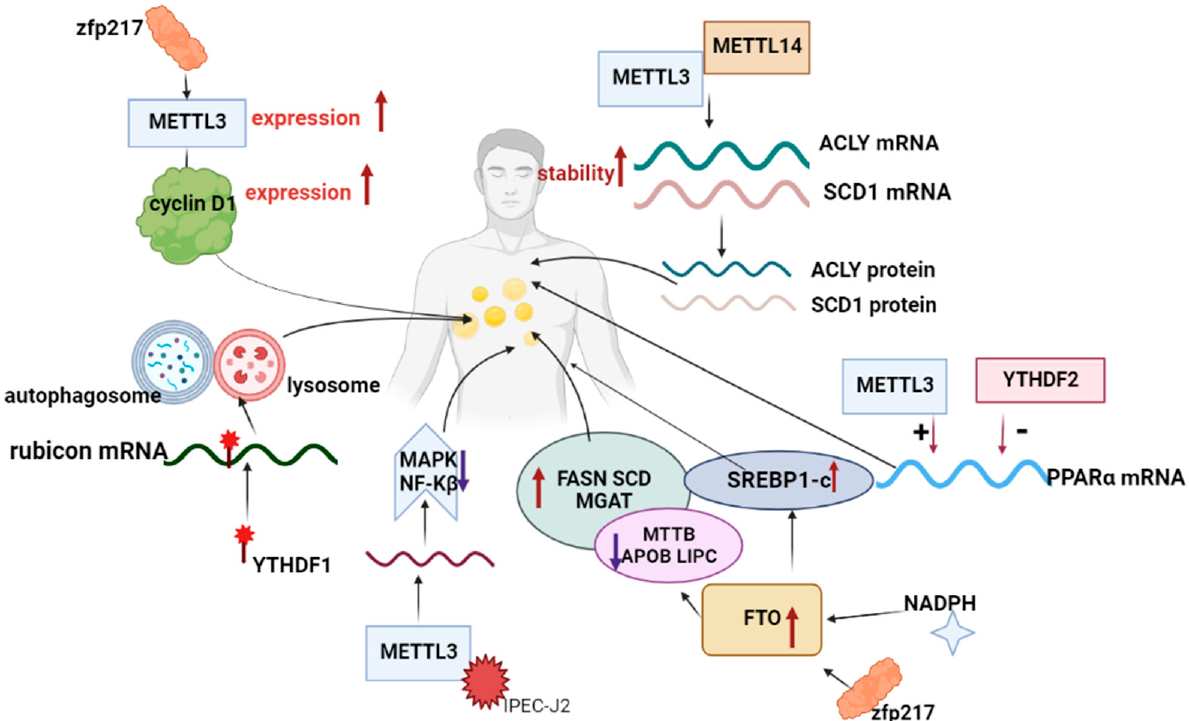
Figure 7. Regulation mechanism of human lipid metabolism by m 6 A.